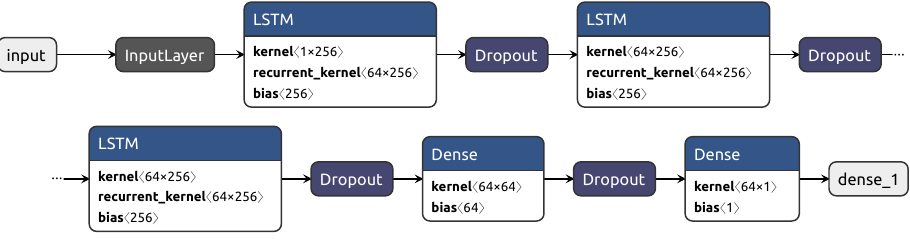
Figure 3. Neural network